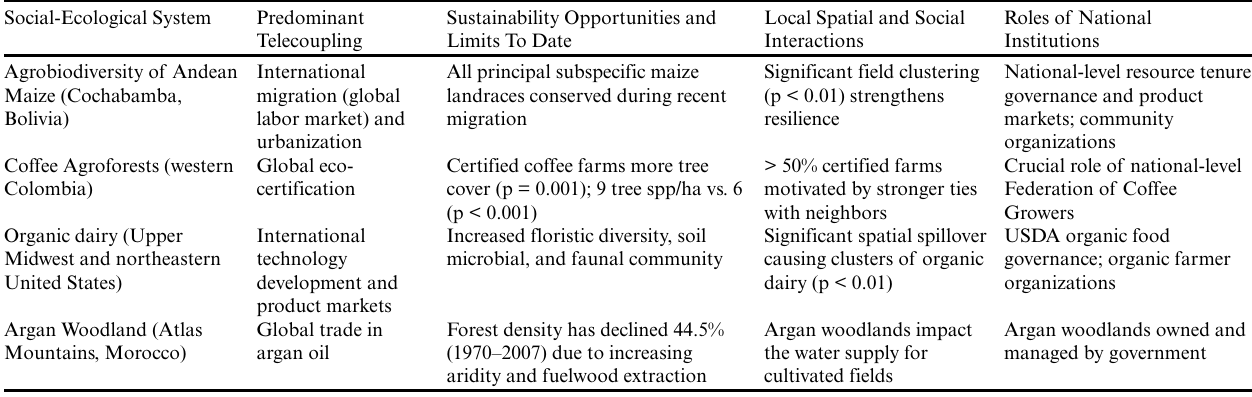
Table 2 . Attributes of the case studies of telecoupled smallholder social-ecological systems (details in each of the case studies) Social-Ecological System